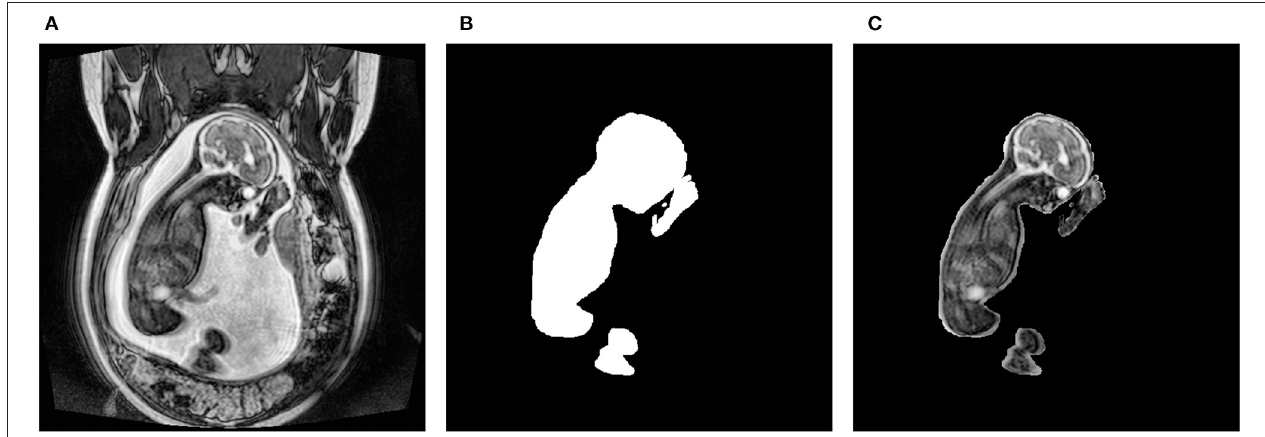
FIGURE 1 | Preprocessing steps to obtain the fetal segmentation. (A) represents the original 2D slice. (B) shows the manually segmented mask. (C) displays the overlay of the mask onto the original slice.